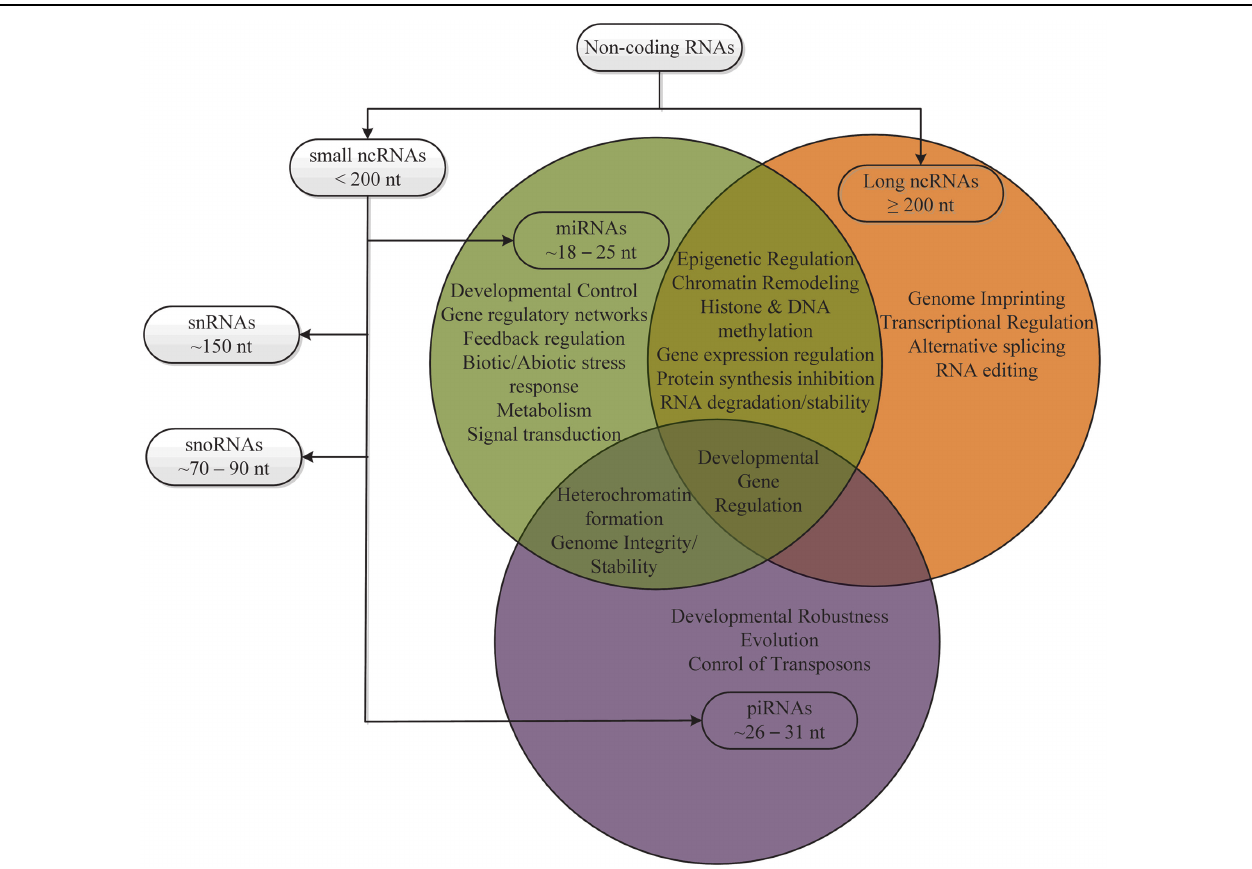
FIGURE 1 | Classification and major functions of various non-coding RNAs.